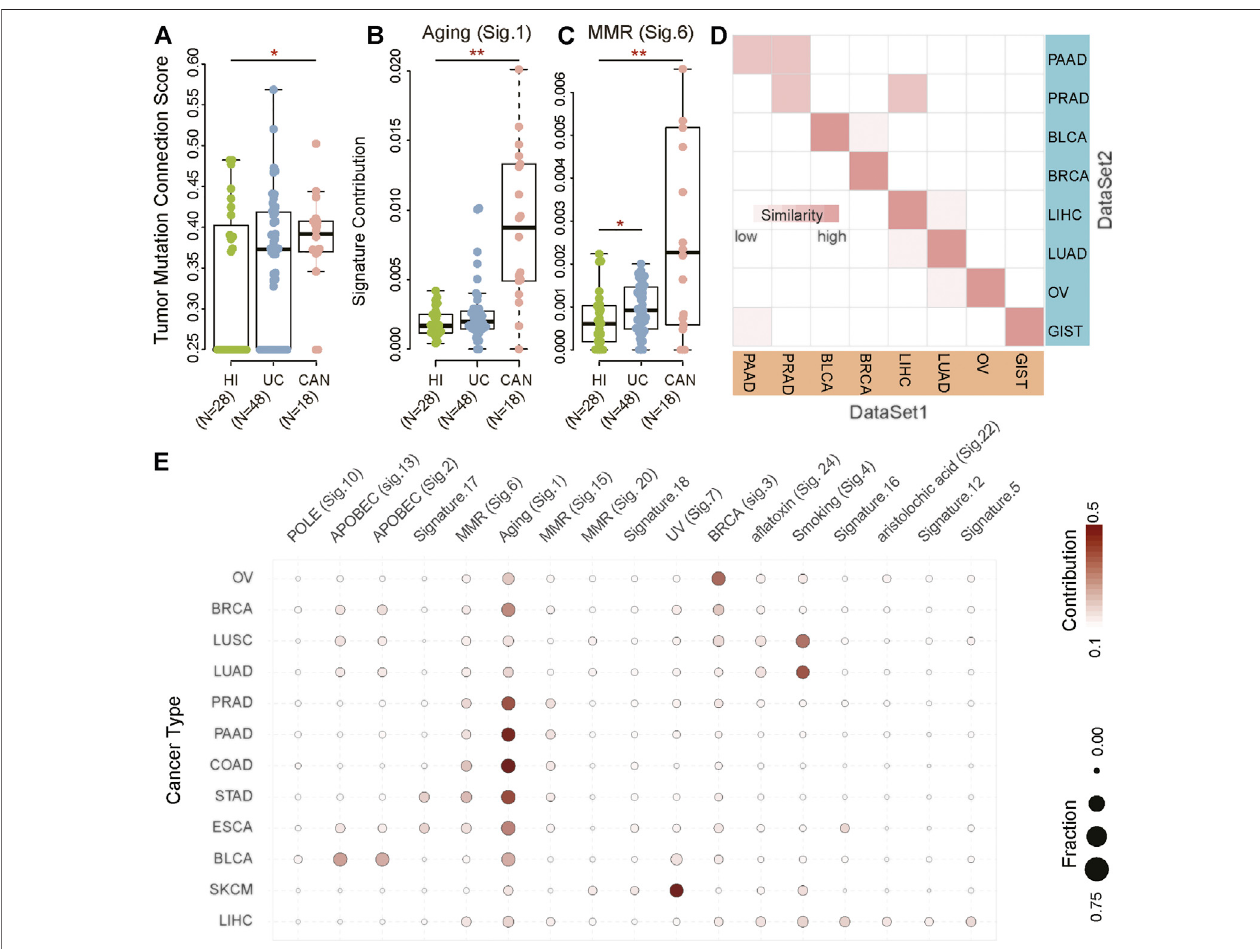
FIGURE 1 | Mutational signatures for cancer diagnosis. (A – C) The biological processes of accumulated mutations in healthy individuals (HI) and patients with ulcerative colitis (UC) and colitis-associated neoplasia (CAN). (D) The correlation between DataSet1 (TCGA) and DataSet2 (previous studies) based on MS in bladder cancer (BLCA), non-small cell lung cancer (NSCLC), pancreatic cancer (PAAD), breast cancer (BRCA), ovarian serous cystadenocarcinoma (OV), liver hepatocellular carcinoma (LIHC), and gastrointestinal cancer, including colorectal cancer (CRC), esophageal carcinoma (ESCA), and stomach adenocarcinoma (STAD). The darker the color, the higher the similarity. (E) Heatmaps of MS in BLCA ( n = 412), NSCLC ( n = 1,108), PAAD ( n = 179), BRCA ( n = 985), OV ( n = 435), skin cutaneous melanoma(SKCM, n =468),LIHC( n =464),CRC( n =398),ESCA( n =184),andSTAD( n =439).ThecolorindicatestheaveragecontributionofMS.Thesizeofthedots indicates the fraction. Fraction: The proportion of samples with a mutational signature contribution of more than 0.06 in each cancer type as a proportion of the total samples. Contribution: Average contribution of each mutational signature in each cancer type.